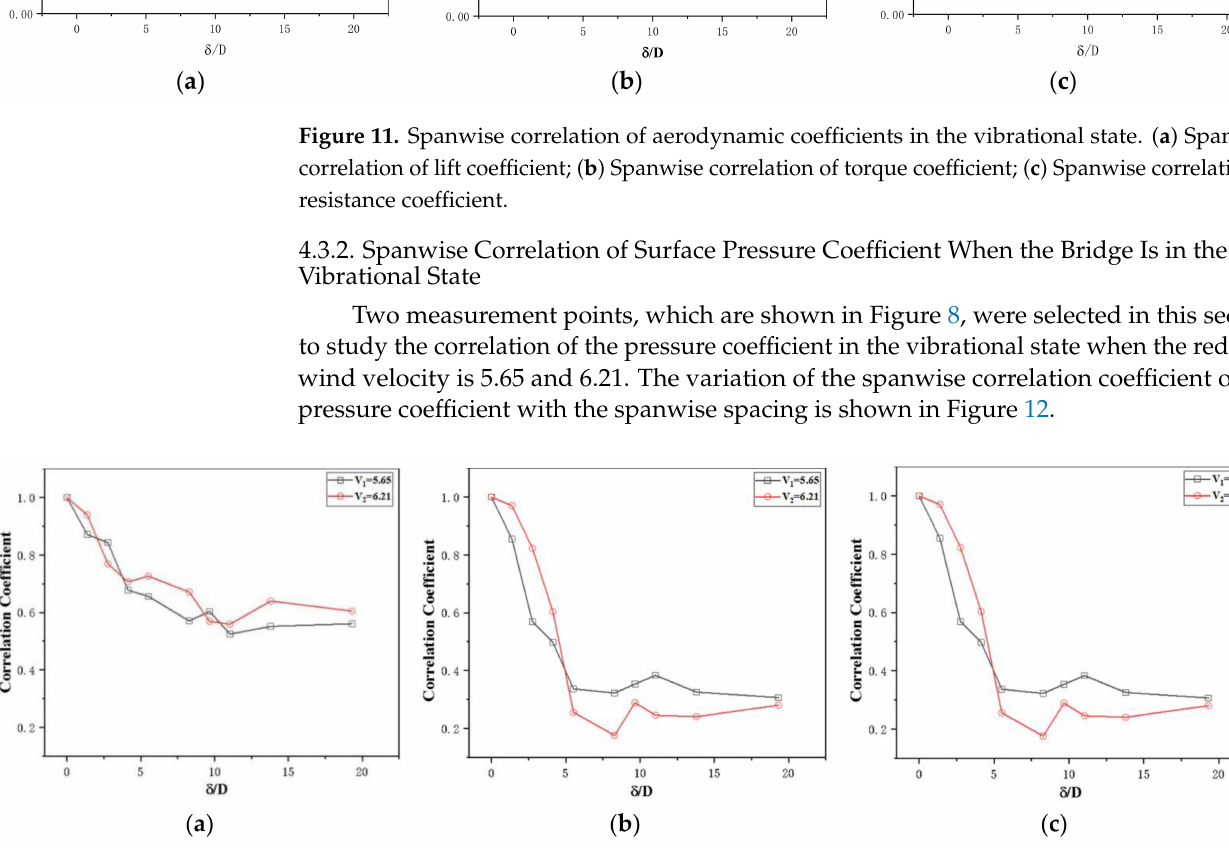
Figure 12. Correlation of pressure coefficient at each measuring point. ( a ) Spanwise correlation of pres- sure coefficient at 1# measuring point; ( b ) Spanwise correlation of pressure coefficient at 2# measuring point; ( c ) Spanwise correlation of pressure coefficient at two measuring points when Vr =